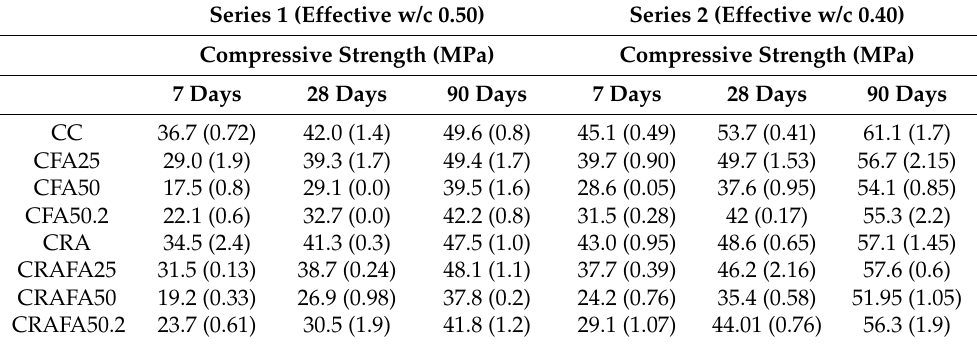
Table 3. Physical properties of concretes produced in Series 1 (with effective w/c of 0.50) and 2 and the compressive strength of concretes at 7, 28 and 90 days. The standard deviation of each average value is given between brackets. Series 1 (Effective w/c 0.50)